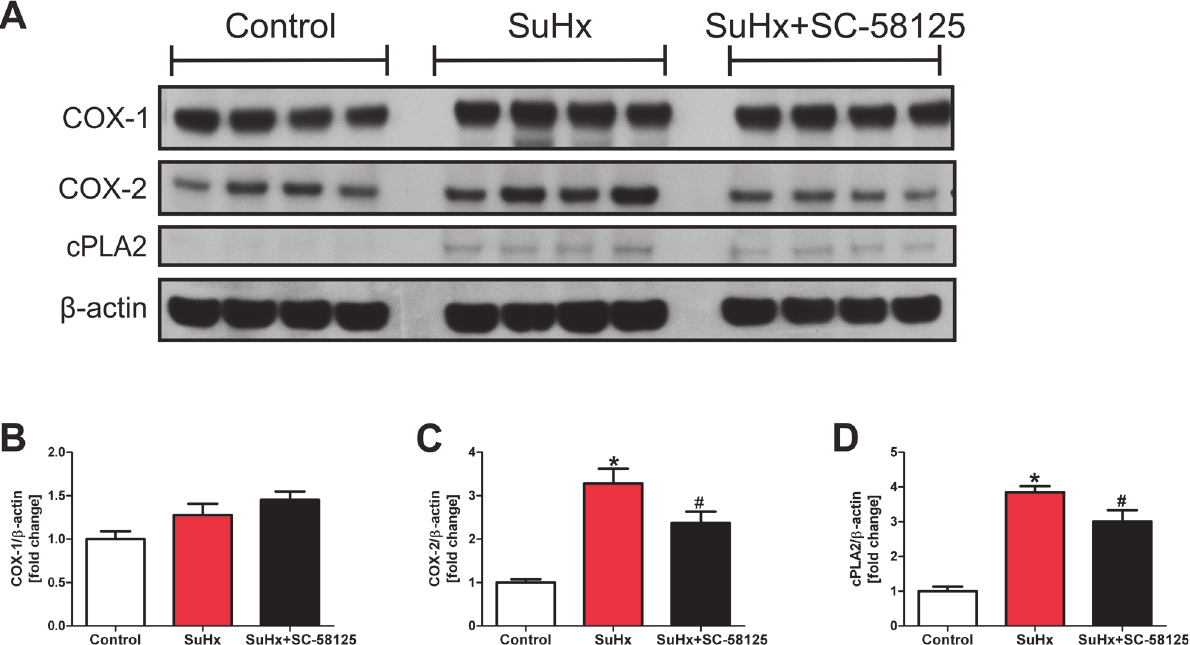
Fig 4. Eicosanoid enzyme protein Western blot data. In lung tissue homogenates there is an increased expression of cPLA2 and COX-2 in the SuHx animals when compared to normal control lung tissues. The overexpression of the COX-2 and cPLA2 proteins is significantly reduced in the lungs from the SuHx animals treated chronically with the COX-2 inhibitor SC-58125 (A). The protein expression is referenced to lung tissue β -actin (B and C). * P < 0.05 vs. control, #P < 0.05 vs. SuHx. (n =